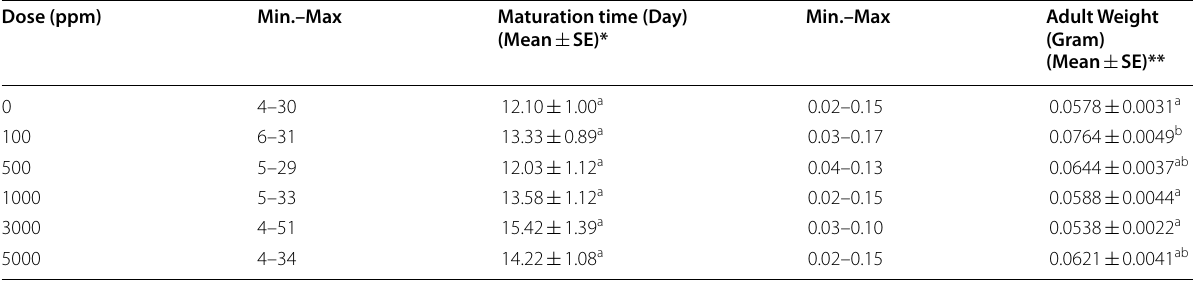
*Kruskal Wallis, P > 0.05